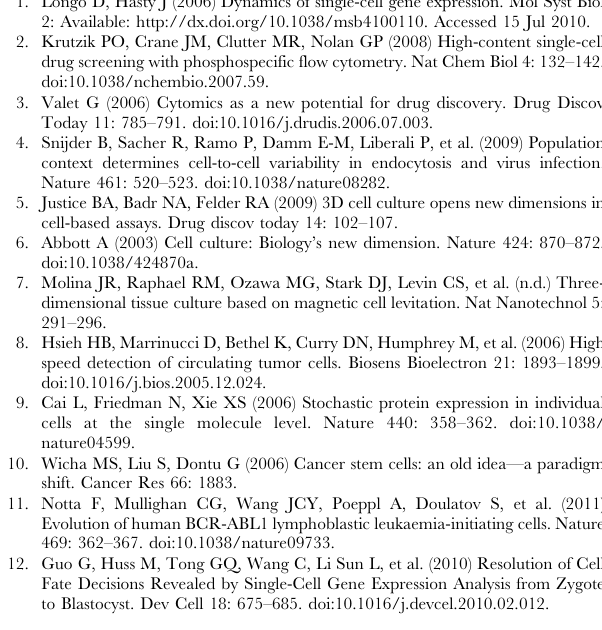
for each well, 200 cells were put to grow on agarose. Values represent mean + / 2 0.5* s.d. n =3. (TIF) Figure S4 Effect of rotation on cell division. (TIF) Table S1 Magnetic HeLa cells viability before and after exposure. (DOC) Table S2 t-Test comparing non-exposed and exposed HeLa cells. The mean of each variable is given as the fraction of viable cells (Two-Sample Assuming Unequal Variances). (DOC) Video S1 Real time video of a magnetized HeLa cell. HeLa cell in DMEM in a 100 um well, under a rotating magnetic field. Frame rate is 26 fps. (AVI) Video S2 Video of a magnetized HeLa cell in goat serum. (Goat Serum Donor Herd, G6767, Sigma-Aldrich H , USA) in a 100 um well, under a rotating magnetic field. Frame rate is 5 fps. (AVI) Video S3 Video of a magnetized HeLa cell undergoing mitosis. (in DMEM in a 100 um well, under a rotating magnetic field. Frame rate is 25 fps).